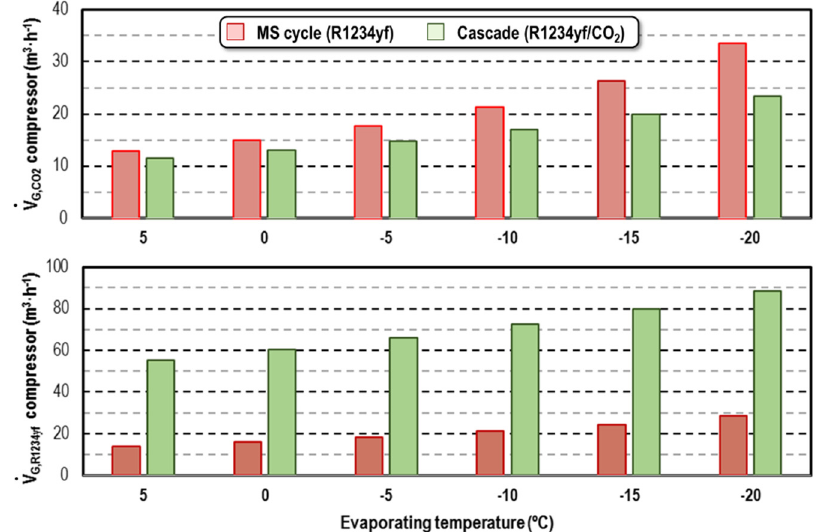
Figure 14. Compressor’s displacements of a plant with 50 kW capacity at an environment at 30 °C.